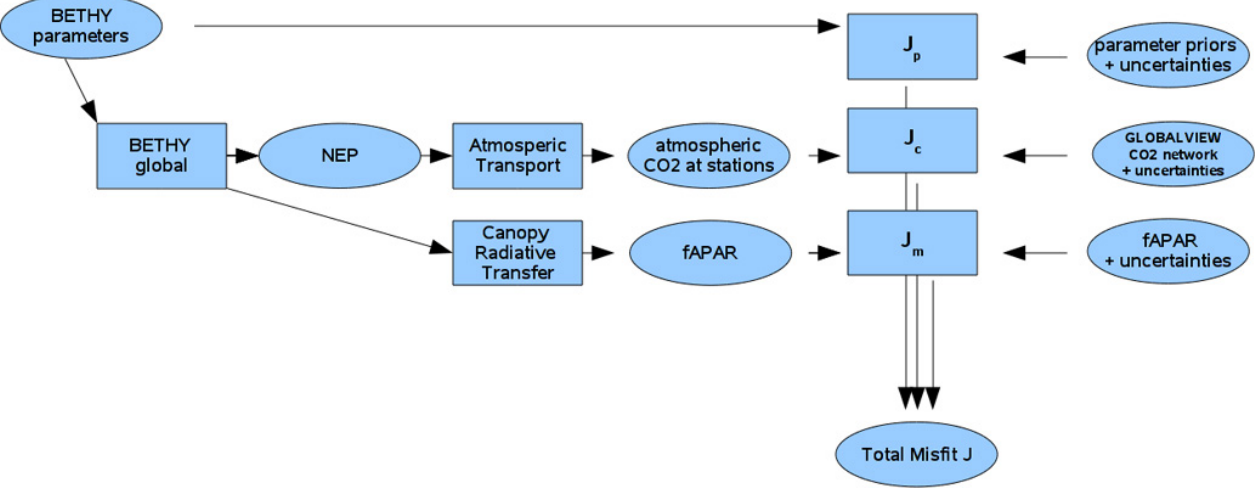
Fig. 1. Flow of information for evaluation of the cost function. J is the sum of the cost function contributions from the individual information items. Ovals denote data and rectangular boxes denote processing (i.e. code